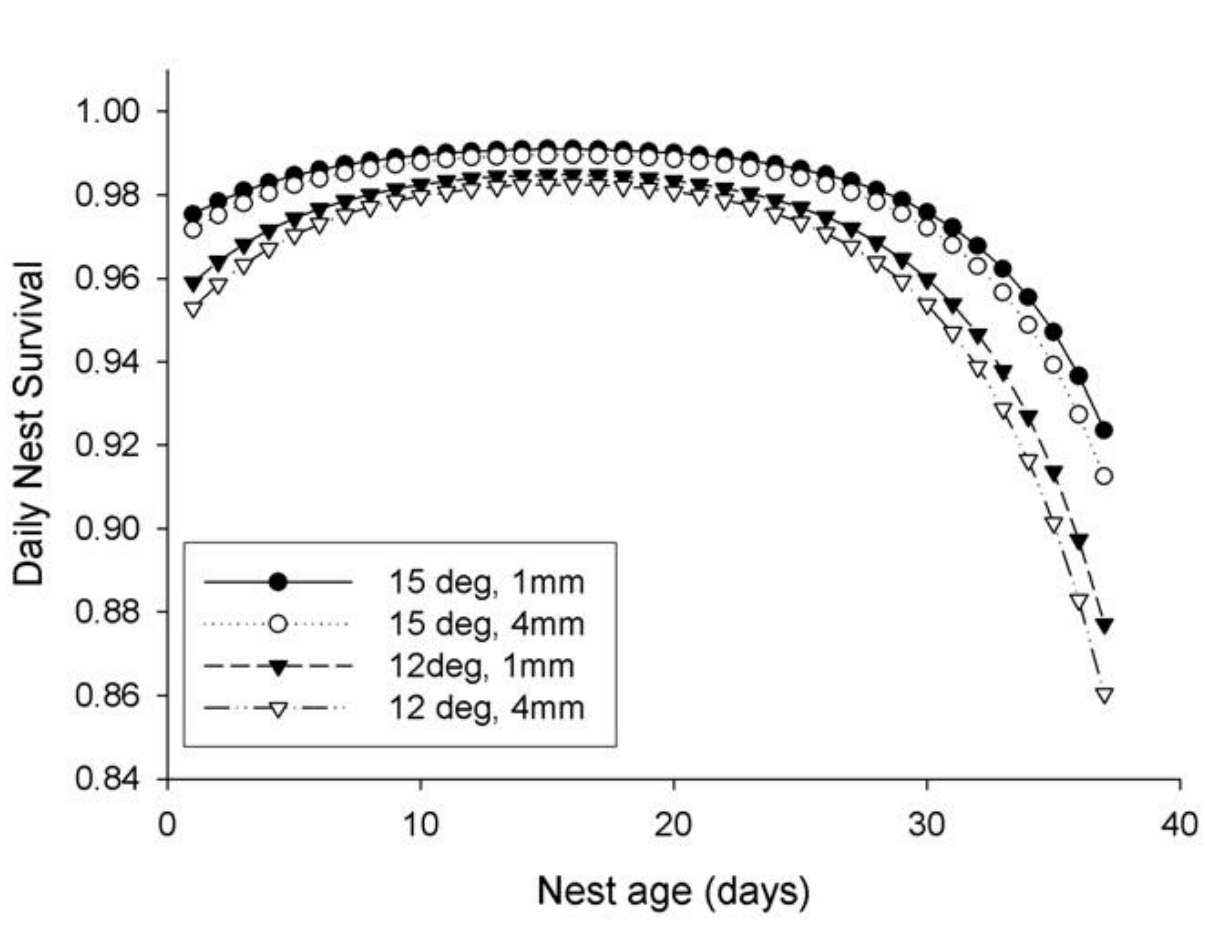
Fig. 1. Change in daily nest survival across the 37-d nest cycle for Loggerhead Shrikes in southeastern Alberta. Values were generated using estimates from the top model (Table 1) and include predicted daily nest survival rates when daily temperature averages 12 and 15°C, and, when precipitation averages 1 and 4 mm per day. Stages of a typical nest cycle include laying (days 1–5), incubation (days 5–20) and nestling (days